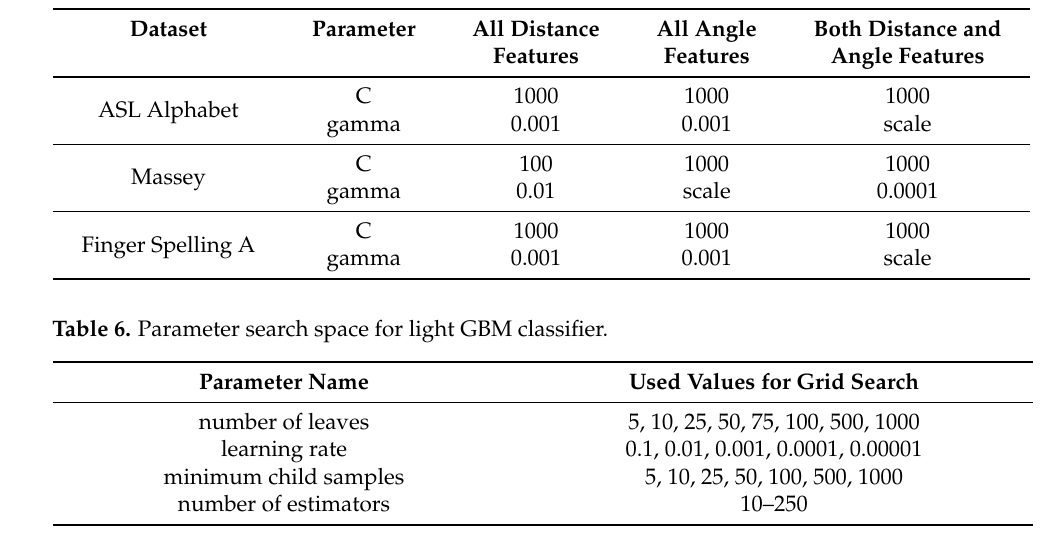
Table 5. Selected parameters of SVM for different datasets.